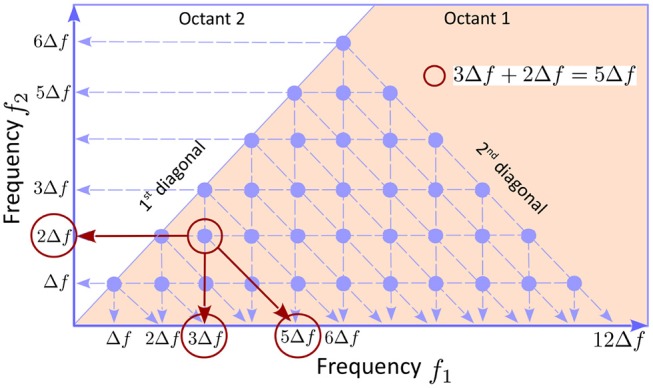
The underlying geometry of a bispectrum plot. The symmetries of the bispectrum (see text) imply that the smallest area in the plans (fn, fm) containing non-redundant information is the first octant, the solid angle between the the f1 axis and first diagonal. Because the bispectrum is computed using discretized frequencies, it is defined only at points (fm, fn) with n, m = 1, ⋯ , N (blue dots; N = 12 here). Because fm + fn ≤ fN, the triads of the type GnGmGm+n* can only be constructed for m + n ≤ N, hence the triangular shape of the bispectral domain. If the bicoherence exhibits a peak (e.g., the red circle) the triad of modes that are phase coupled can be identified as the coordinates of the peak, together with the intersection between the horizontal axis and a parallel to the second diagonal passing through the peak (red arrows).